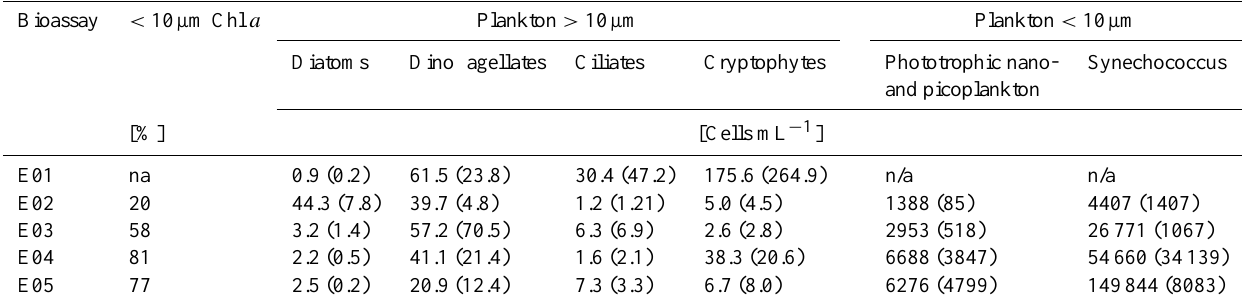
Table 4. Initial plankton community composition for each of the main experiments. Average ( ± standard deviation) values are given when